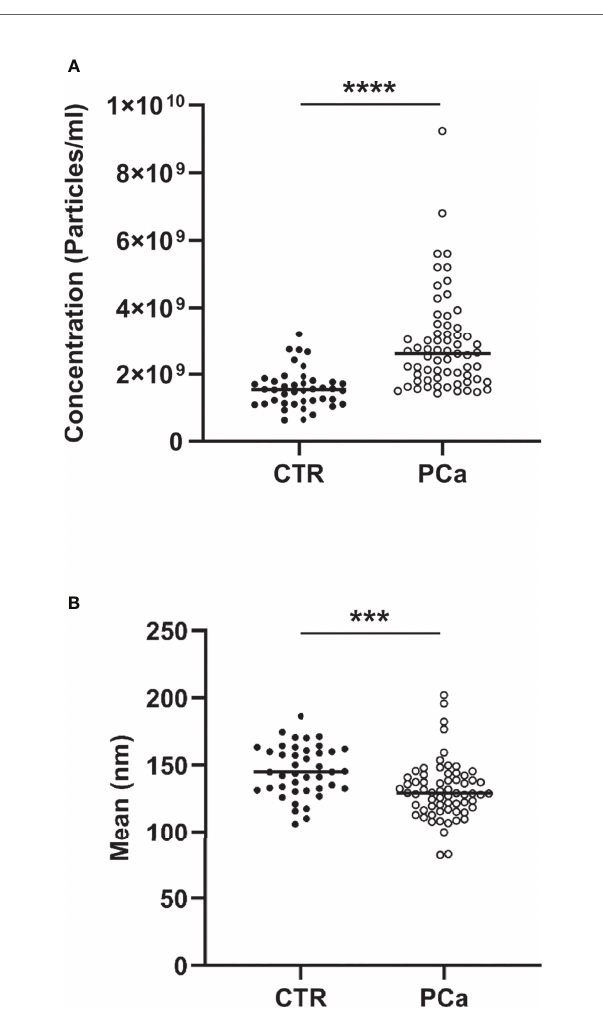
FIGURE 2 | NTA distribution and quanti fi cation of CTR and PCa plasmatic exosomes by concentration (A) and size (B) parameters included within the 25th and 75th percentiles.*** p < 0.001, **** p <